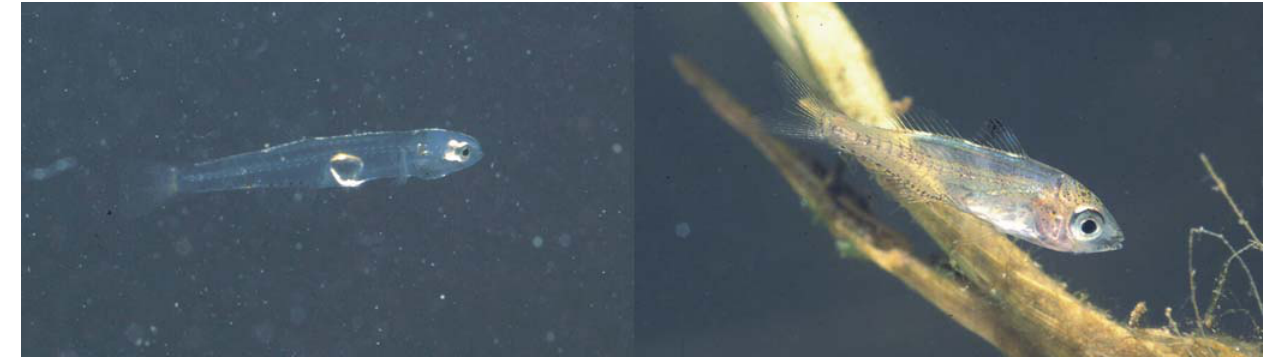
Fig. 4. A larval Eleotris pisonis (8.8 mm SL, ZUEC 6169, left) and a juvenile Eucinostomus melanopterus (11.3 mm SL, ZUEC 5378, right) photographed in field aquarium under artificial light.